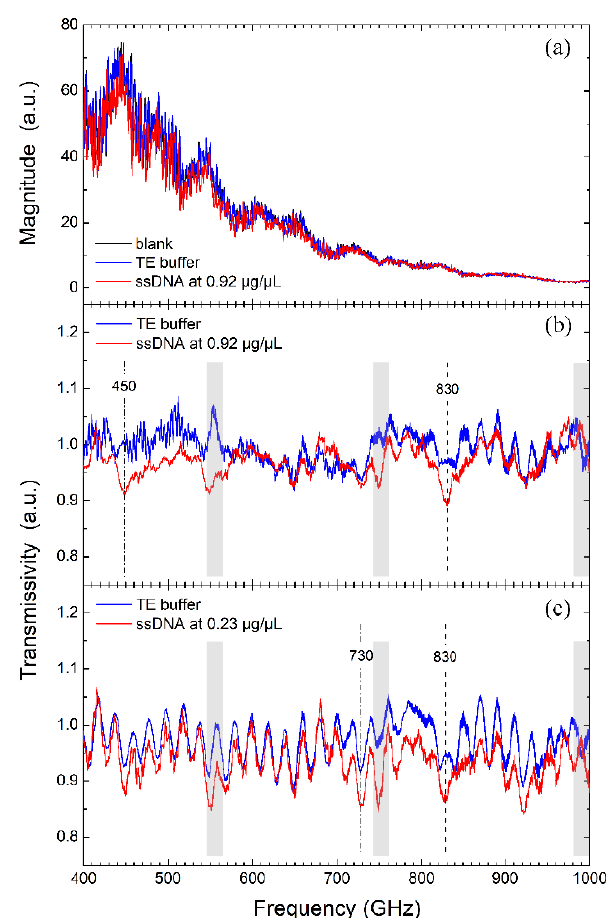
Figure 3. ( a ) Transmission spectra of the blank chip, the TE buffer and the ssDNA at 0.92 μg/μL; Transmission spectra of the microfluidic chip containing pure TE buffer relative to the blank chip (blue curve), and the microfluidic chip containing DNA solutions relative to the blank chip (red curve) at 0.92 μg/μL ( b ) and at 0.23 μg/μL ( c ).